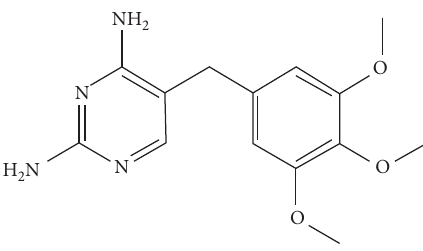
Figure 1: Trimethoprim